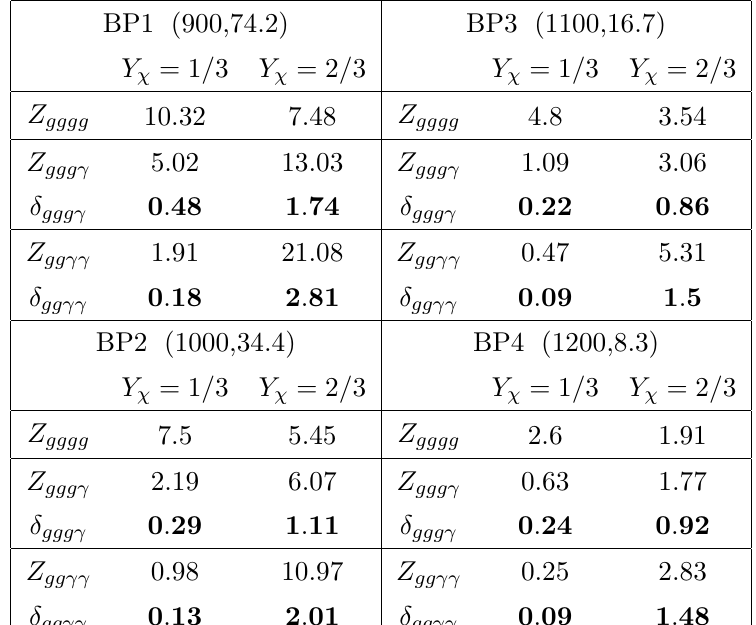
Table 6 . Estimation of signal sensitivities ( Z ) and ratio (cid:14) for di(cid:11)erent channels at HL-LHC with 3 ab (cid:0) 1 of integrated luminosity. The multi-jet background at this luminosity is obtained by scaling the events multiplicities from 35 fb (cid:0) 1 . The benchmark points are denoted by ( M (cid:8) [GeV] ; (cid:27) prod [fb]).